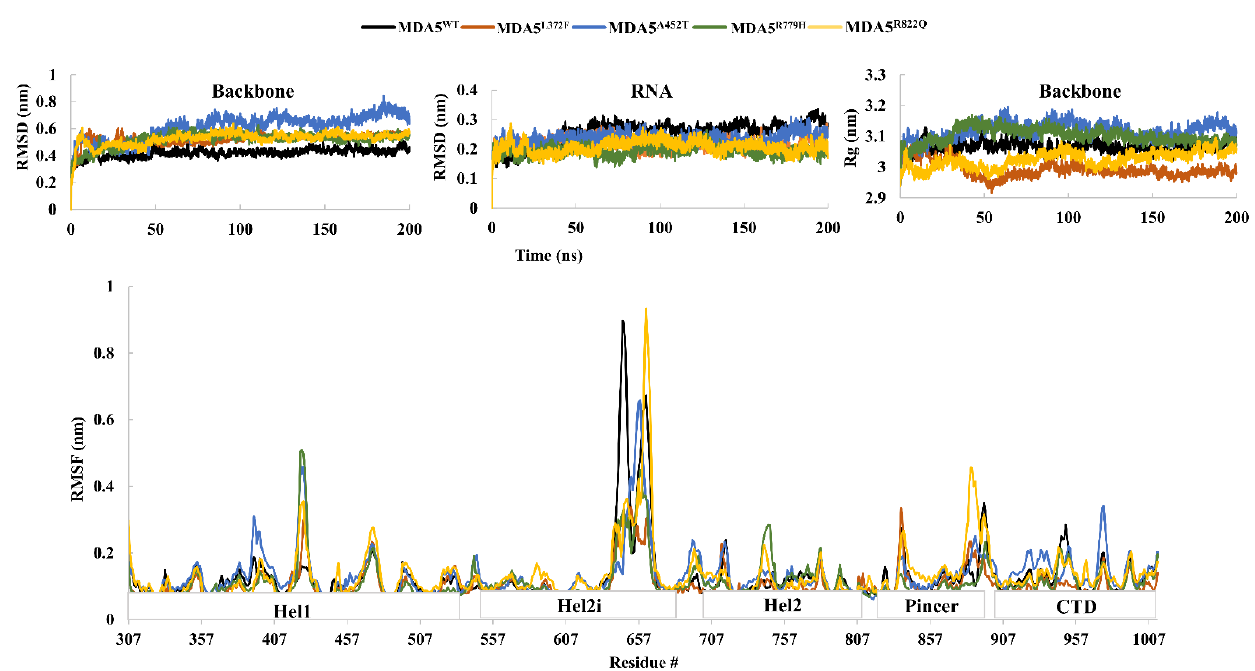
Figure 2. Molecular dynamics trajectory analysis. Protein backbone root mean square deviation (top left). Root mean square deviation of dsRNA (top middle). Radius of gyration of the backbone atoms of MDA5 (top right). Root mean square fluctuations of the backbone atoms of MDA5 (bottom).